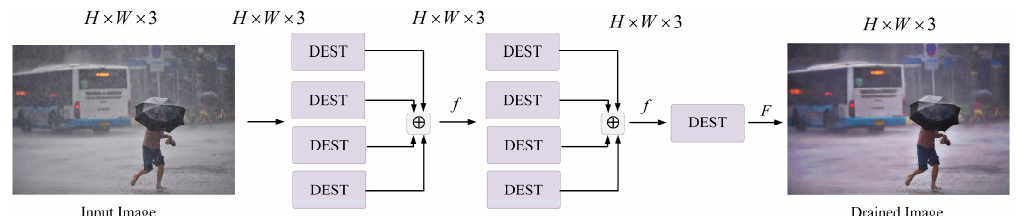
Figure 2. The derain model.